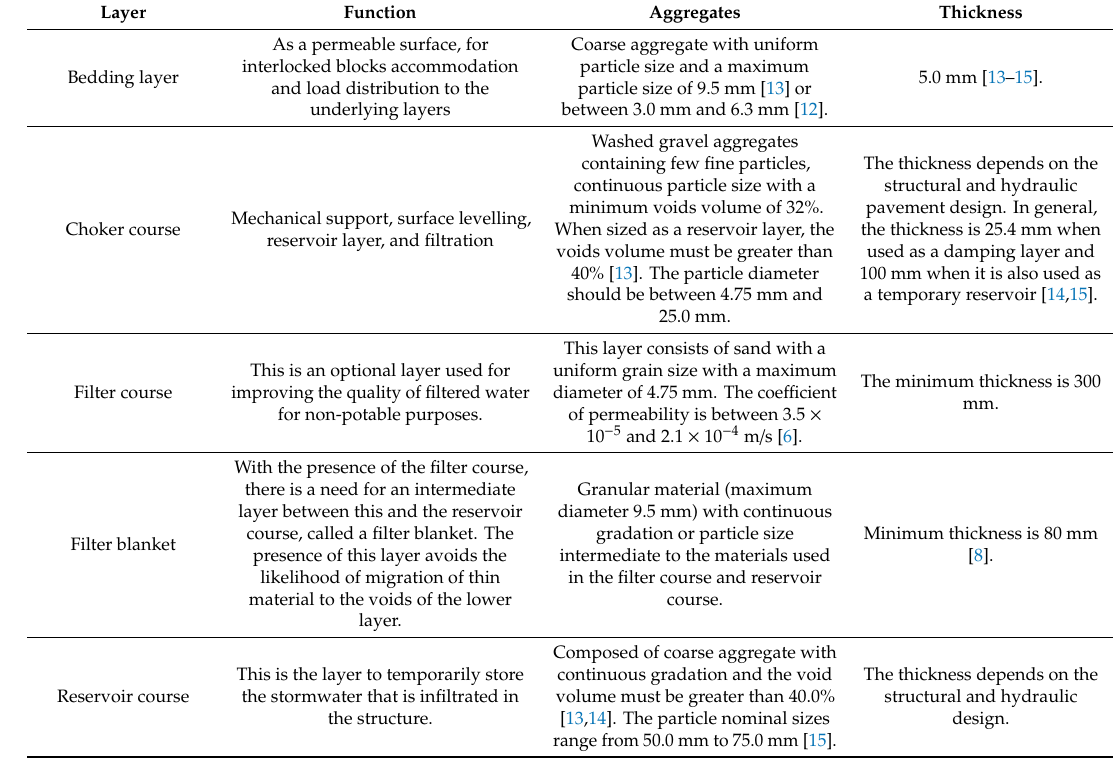
Table 1. Permeable interlocking concrete pavement